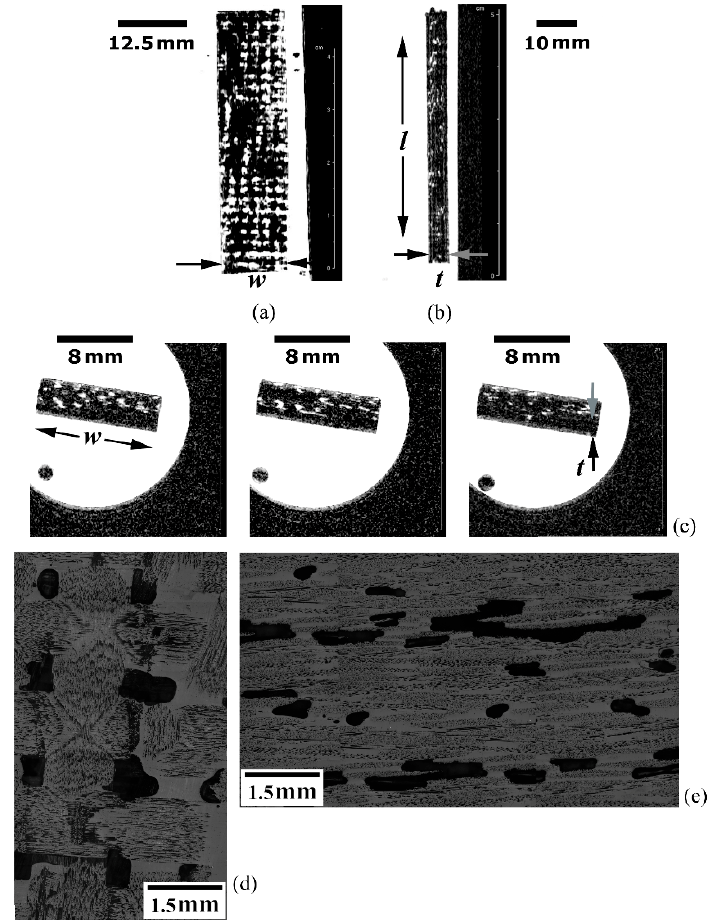
Figure 6. Water absorption analysis of the defective EPX-GF specimen: ( a ) C-view at the specimen mid-thickness; ( b ) S-view at the specimen mid-width; ( c ) parallel slices according to the A-view at the specimen mid-length; and ( d , e ) microscopic cross-section views corresponding to, respectively, C and A tomographic planes.